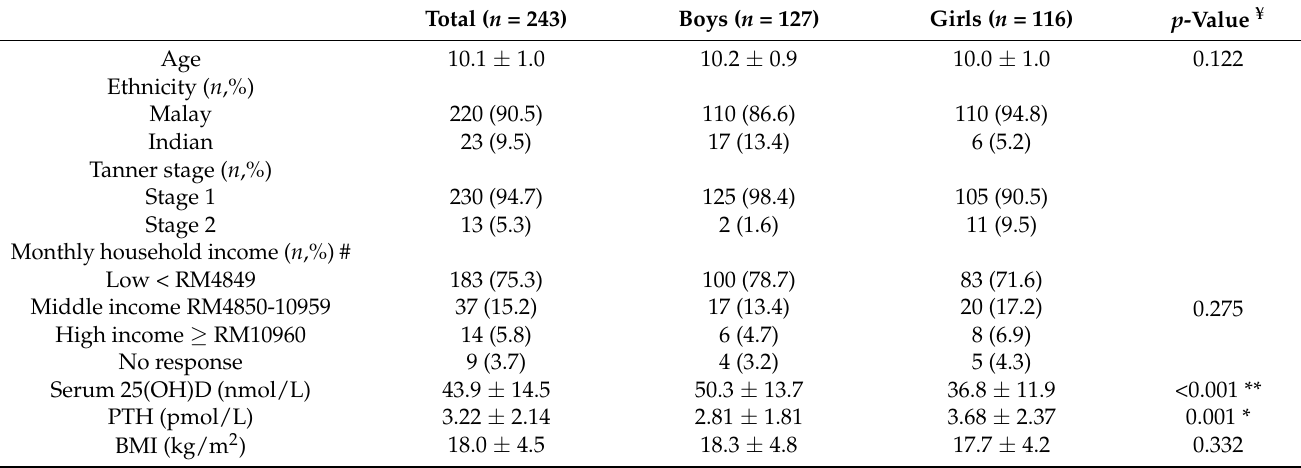
Table 1. Descriptive characteristics of participants ( N =